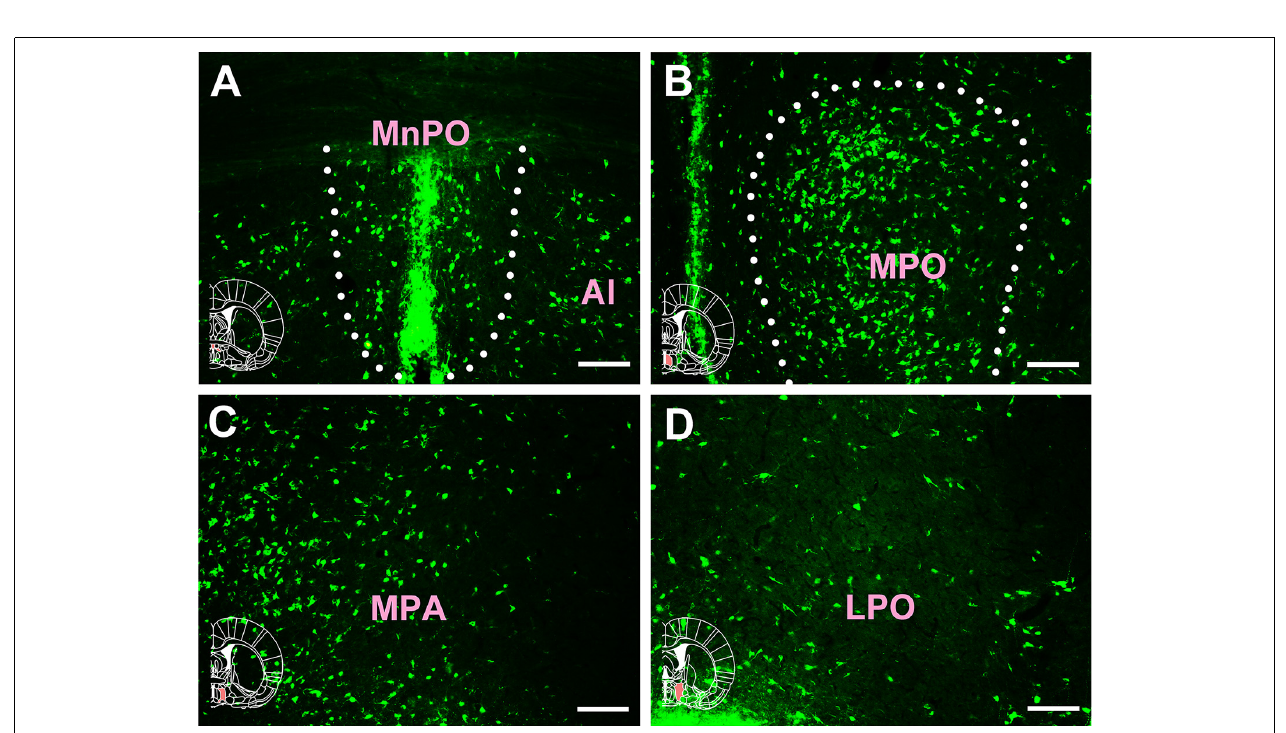
FIGURE 5 | Distribution of cholera toxin subunit B-positive neurons in the circumventricular organs. (A,B) The positive neurons in VOLT and SFO. (C) Statistics of the input amounts of cholera toxin subunit B-positive cells from the circumventricular organs to the CSF-contacting nucleus (mean ± SD, n = 6; VOLT, vascular organ of the lamina terminalis; SFO, subfornical organ). Bar = 100 µ m.